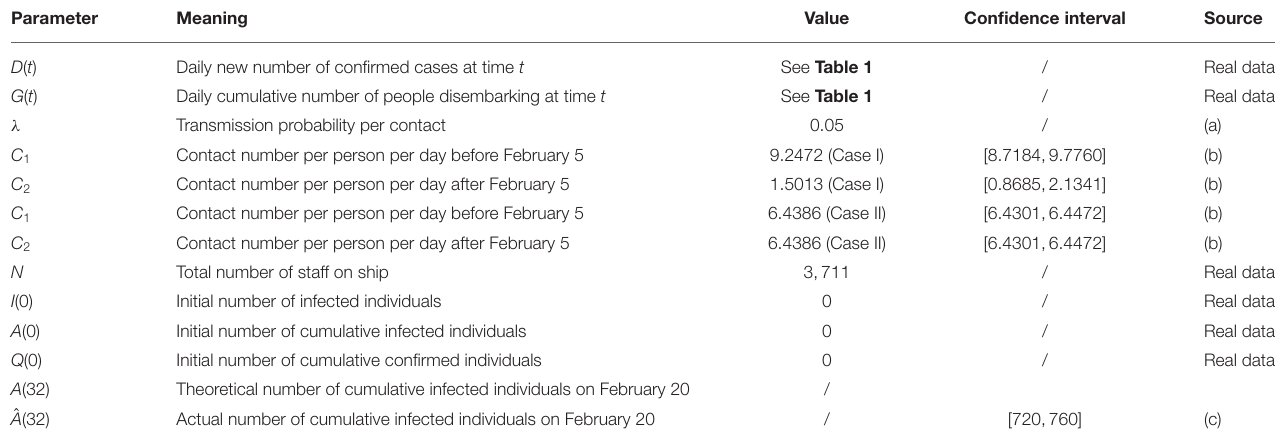
TABLE 2 | Values of parameters and variables in model (1). Parameter